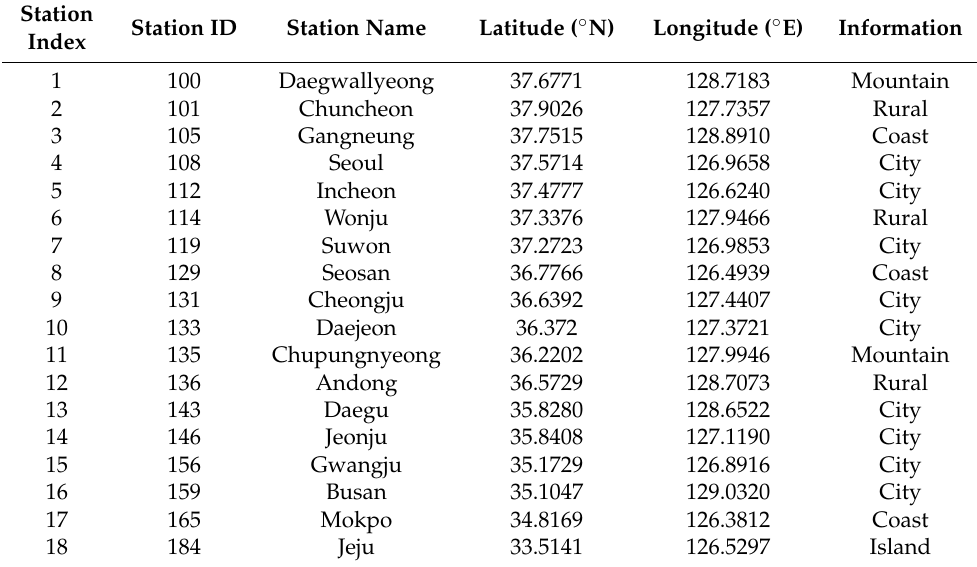
Table 1. Summary of the details for the ground observation stations.